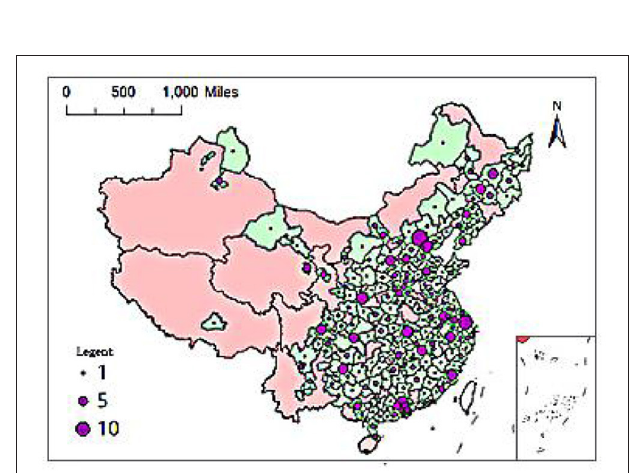
FIGURE 2 | Spatial distribution of city-level unit